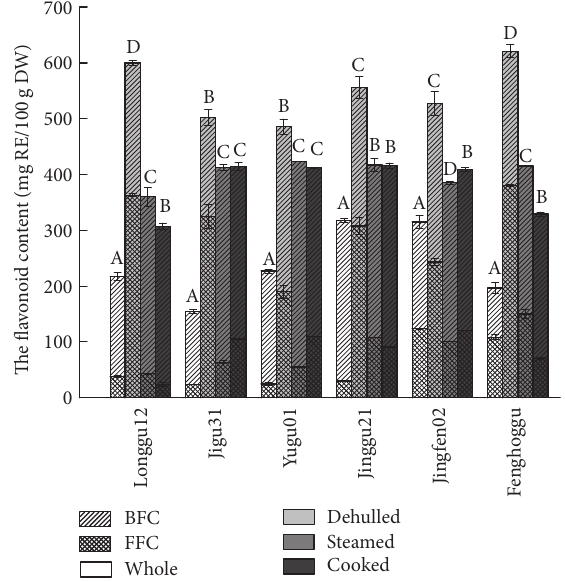
Figure 3: The FFC, BFC, and TFC of 6 cultivars of foxtail millet with different treatment. Error bars represent the standard deviation ( ± SD). The different uppercase letters (A–D) indicate significant differences of TFC within different processing methods of the same cultivar ( 𝑃 < 0.05